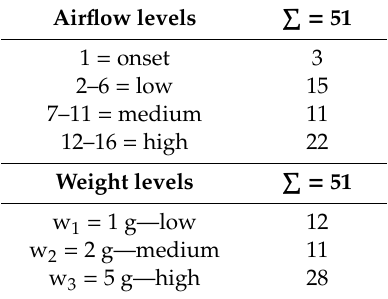
Table 3. Frequencies of the test-runs divided into the di ff erent airflow levels and elongation